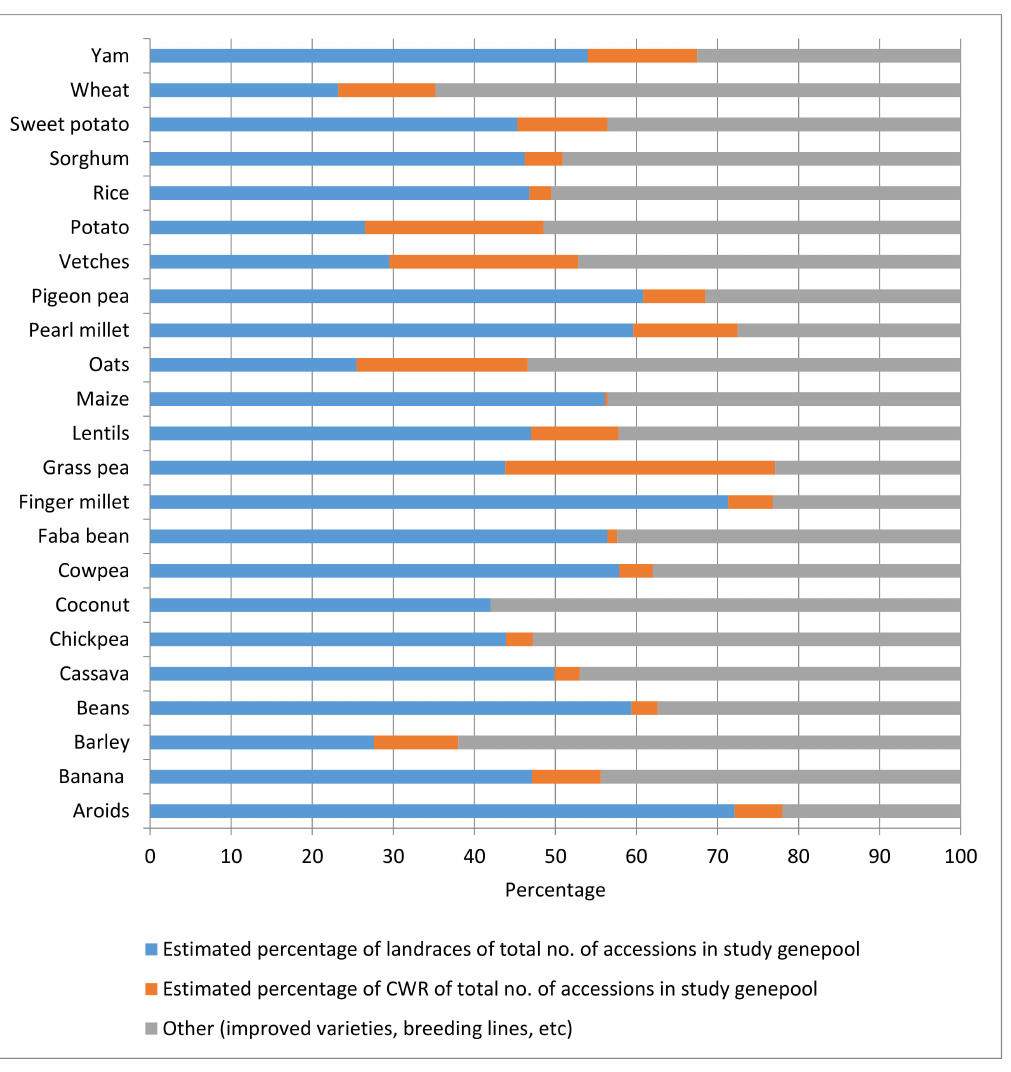
Figure 1. Percentages of CWR and landrace accessions in genebank collections of 23 selected crop